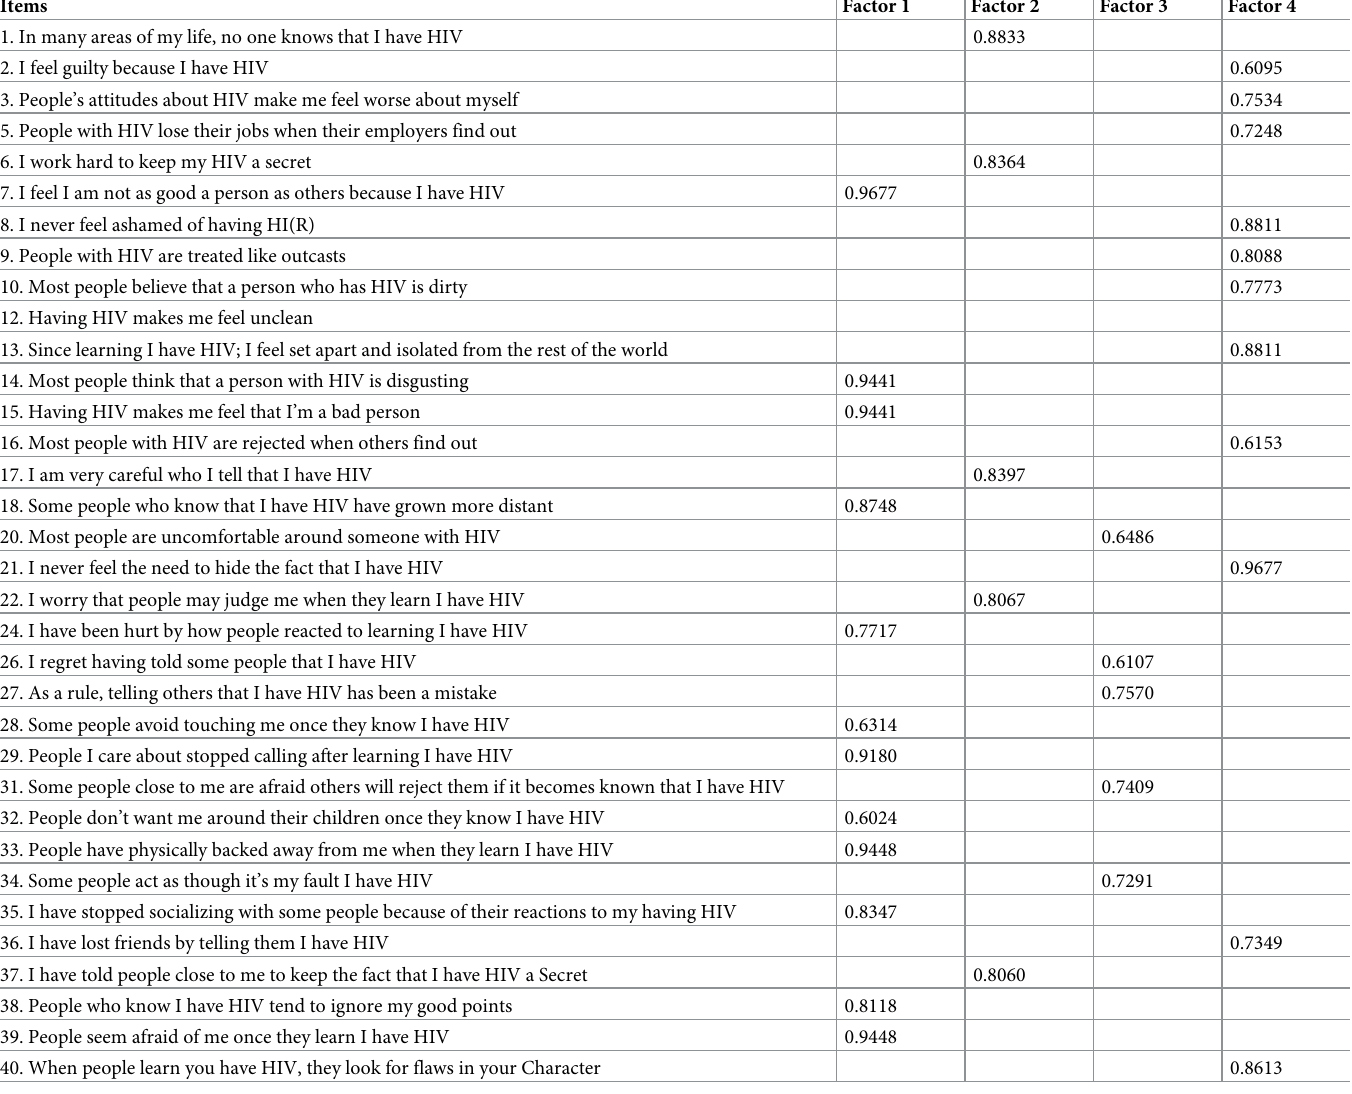
Table 2. Factor loadings > 0.6 for items in the HIV stigma